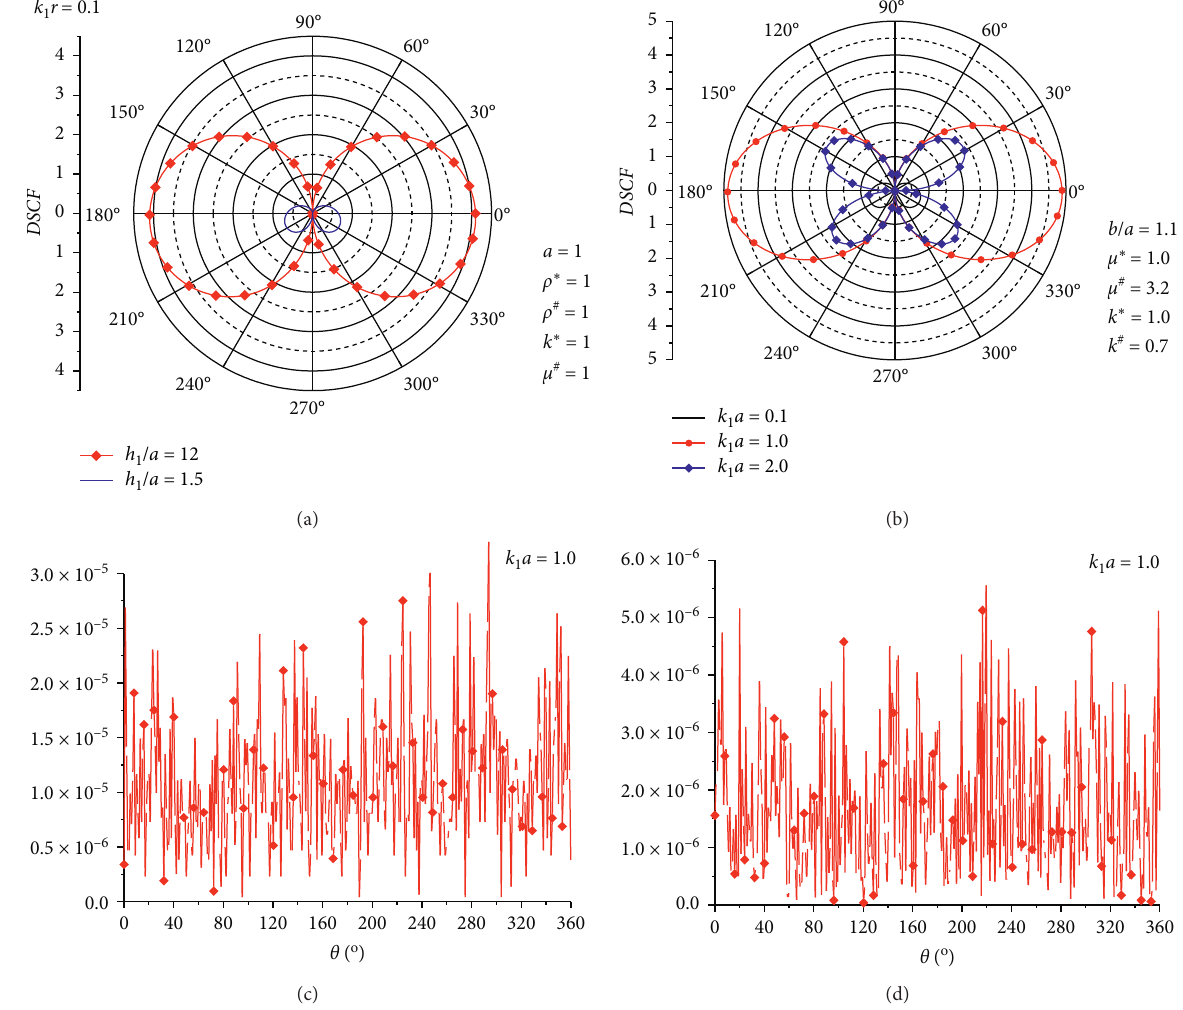
Figure 6: The verification calculation when degenerated into the half-space problem. (a) DSCF along the edge of a cavity in half-space. (b) DSCF along the inner surface of a circular lining in half-space. (c) Residual radial stress on the inner surfaces of a circular lining in half-space. (d) Residual radial stress on the outer surfaces of a circular lining in